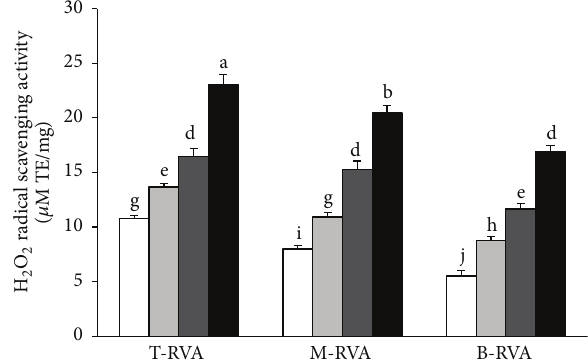
Figure 2: The effect of RVA on H 2 O 2 radical scavenging activity. a – i Values not sharing a common letter are significantly different at 𝑃 < 0.05 by Dunnett’s multiple range tests. Light gray square, 125 𝜇 g/mL; gray square, 250 𝜇 g/mL; dark grey square, 500 𝜇 g/mL; black square, 1,000 𝜇 g/mL.